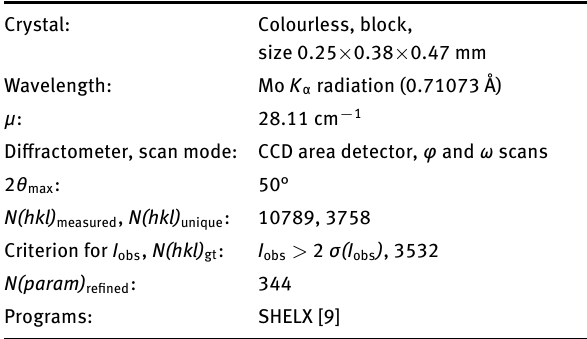
Table 2: Fractional atomic coordinates and isotropic or equivalent isotropic displacement parameters (Å 2 ).